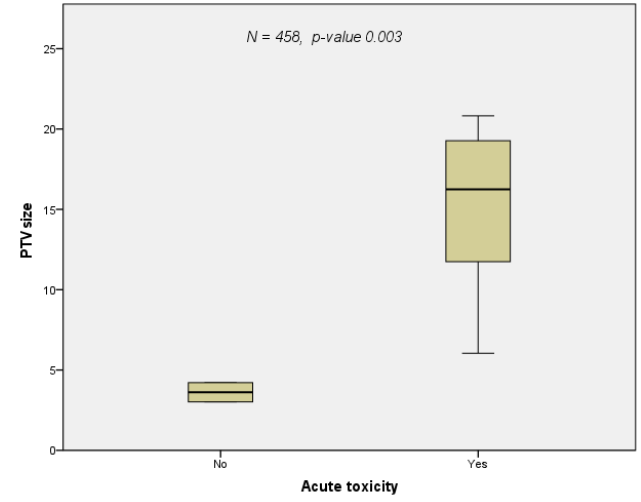
Figure 4. The occurrence of acute toxicity grade 1 to 4 versus PTV size at re-irradiation: patients who experienced acute toxicity grade 1 to 4 had a larger PTV compared with those without (Pearson correlation, p -value = 0.033). The studies by Kilburn and Ohguri could not be included in this calculation since they did not contain information on PTV size, hence the number of patients was reduced to 458.